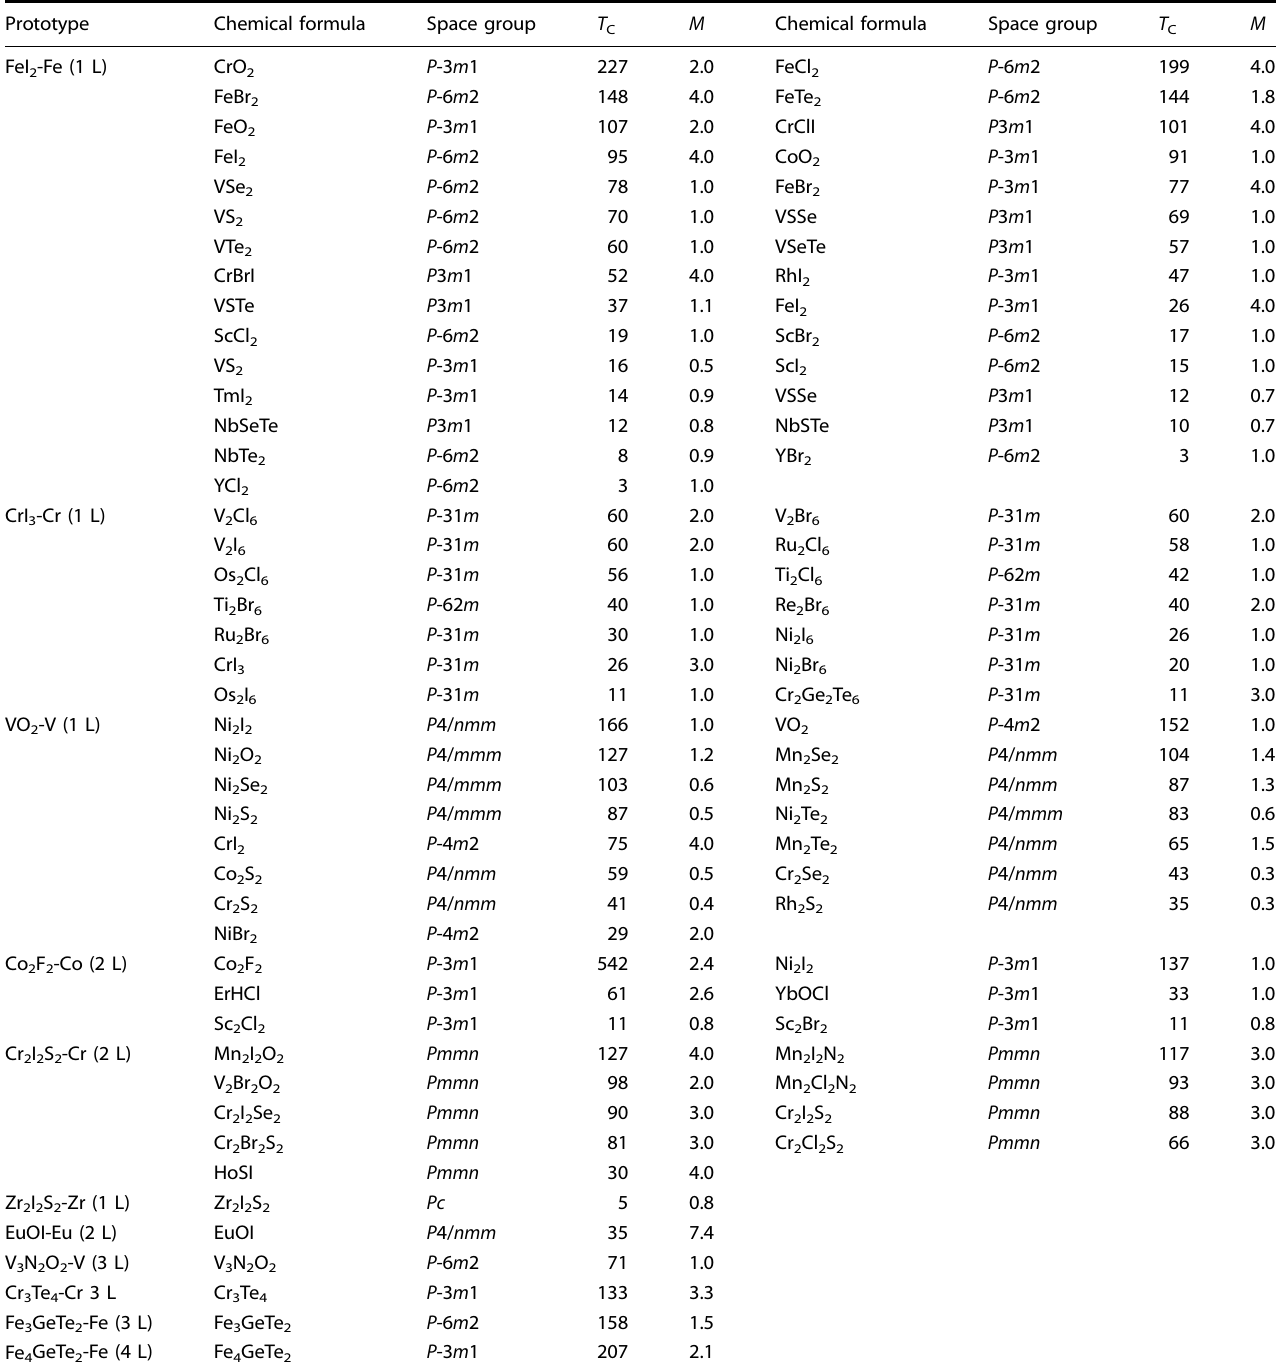
Table 1. The structural prototypes of the 2DFM materials, and the chemical formula, space group of each compound.